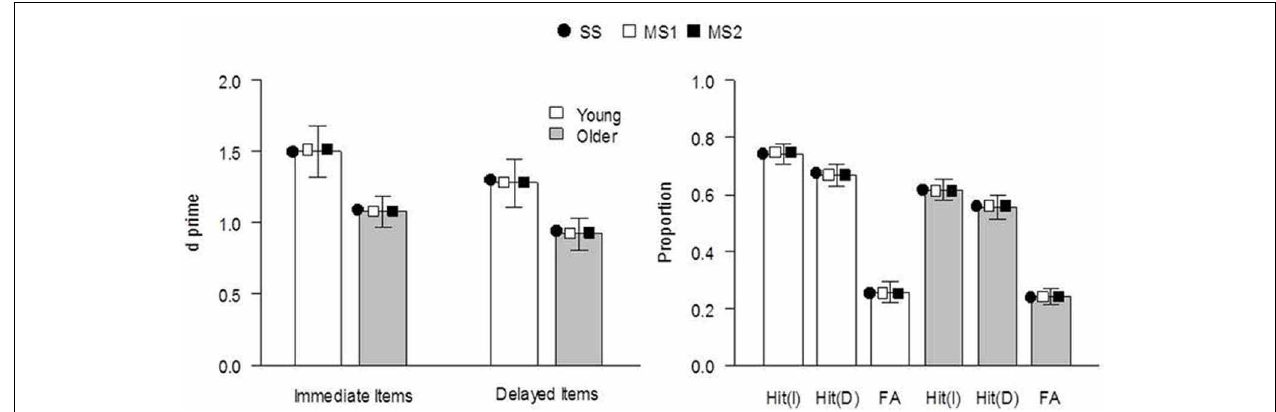
FIGURE 1 | Recognition performance for immediate and delayed items in Ward et al. (2013), Experiment 1. Left panel: discriminability performance ( d (cid:3) ) [significant main effect of age group, F ( 1 , 38 ) = 4 . 26, p = 0 . 04, η 2 p = 0 . 10, and delay, F ( 1 , 38 ) = 5 . 76, p = 0 . 02, η 2 p = 0 . 13, and no significant interaction, F ( 1 , 38 ) = 0 . 16, p = 0 . 69]. Right panel: proportion of